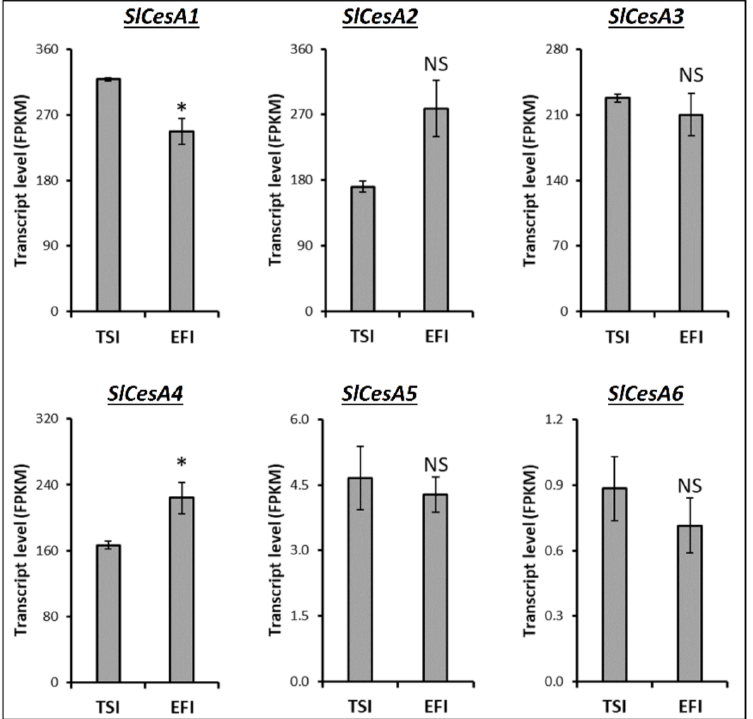
Figure 11. Effect of top sprinkle (TSI) and ebb-and-flow (EFI) irrigation on transcript profiling of cellulase metabolism-related genes in tomato roots. Vertical bars indicate means ± SE (3 biological and 3 techincal replicates). The * represents significance at p ≤ 0.05, according to Student’s t -test. NS–not